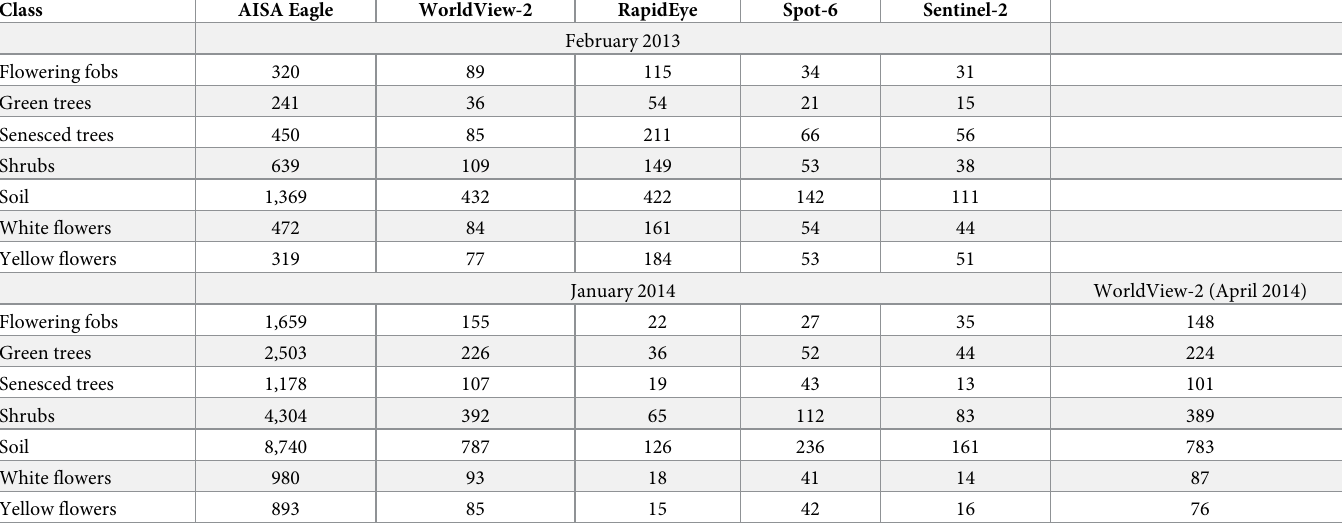
Table 5. Field reference data used in the classification of the various flowering and other plant classes from different image datasets. 70% of the data were used for training while 30% were used to test the accuracy of the random forest classification models. Class AISA Eagle WorldView-2 Spot-6